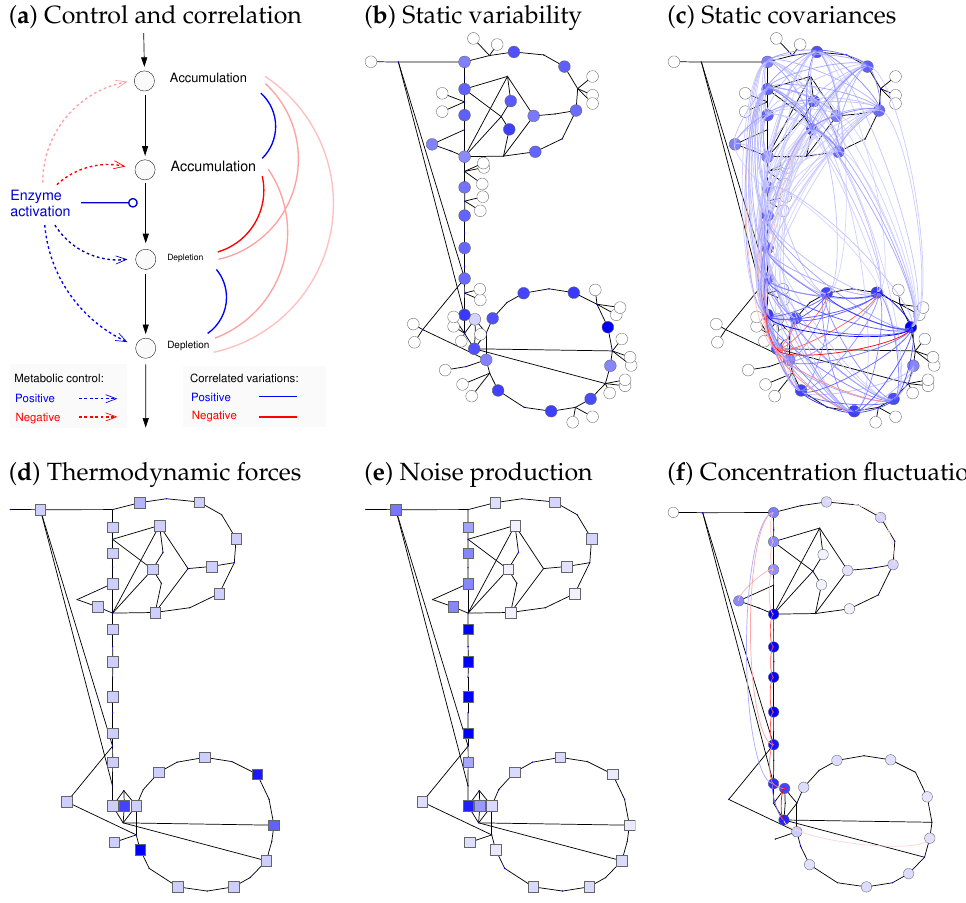
Figure 6. Static changes and dynamic fluctuations of metabolite concentrations. ( a ) Variability of metabolic states caused by perturbed reaction rates (schematic drawing). An enzyme activation (left) increases a single reaction rate (solid arrow), which changes the steady-state metabolite concen- trations and fluxes (dotted arrows). Similarly, variability in enzyme activities (quasi-static random changes) causes slow correlated metabolite variability (curved lines on the right, blue: positive; red: negative); ( b ) variation of metabolite concentrations in E. coli central metabolism (Figure 3) caused by uncorrelated variable enzyme concentrations (geometric standard deviation of enzyme levels: 2). Standard deviations of log concentrations are shown by colours; ( c ) correlated metabolite variations (covariances of log concentrations) are shown as coloured lines (values below 10% of the maximal value were removed for clarity). Metabolite variances (in ( b )) and covariances (in ( c )) computed from first-order response coefficients. Local enzyme fluctuations lead to network-wide metabolite fluctuations: the frequency spectra are related by spectral response coefficients. ( d ) Thermodynamic forces (same data as in Figure 3d). Effects of chemical noise in a cell volume of 2 µ m 3 and with a glycolytic flux of 1 mM/min; ( e ) reactions close to equilibrium (small thermodynamic forces) produce strong chemical noise because of their large forward and backward fluxes. Spectral power density of the original noise; ( f ) resulting metabolic fluctuations: fast fluctuations at a frequency of 1 s − 1 . Formulae are given in Supplementary Section